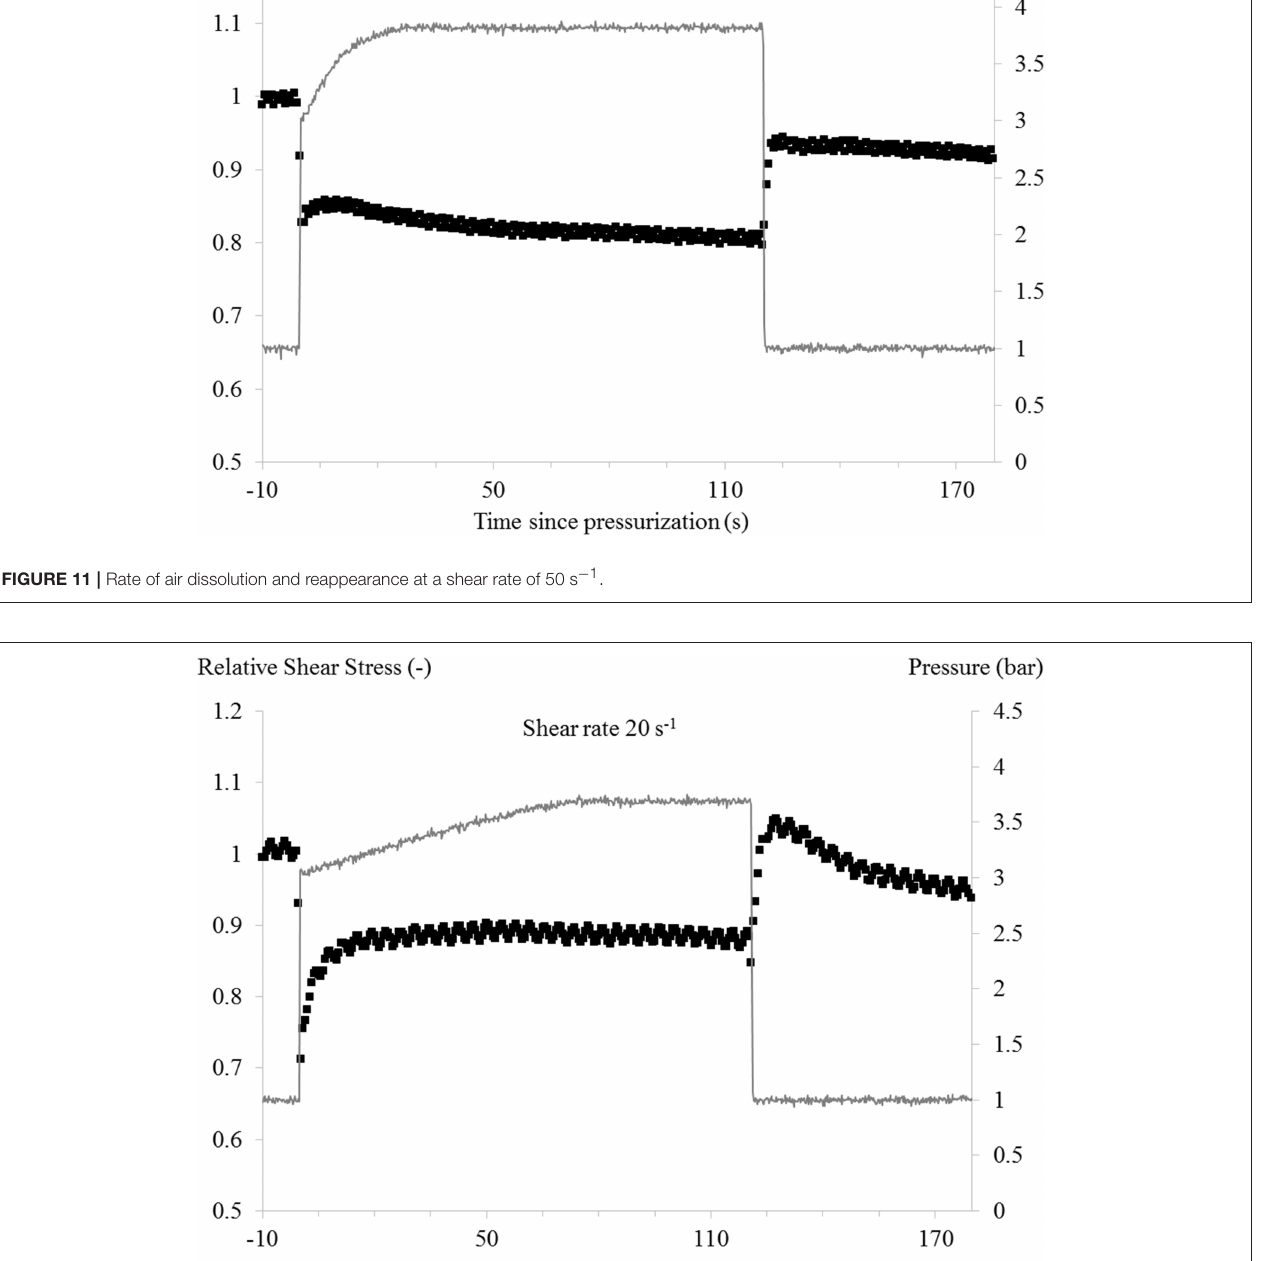
deformation behavior of the air bubbles is uncertain (Rust and Manga, 2002). However, as air is assumed to reappear in existing bubbles at depressurization, the average bubble size increases, increasing the average Ca . As Ca is also proportional to